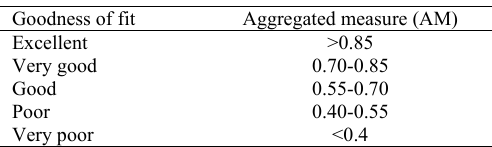
Table 3: Model efficiency classes (Safari et al., 2012) Goodness of fit